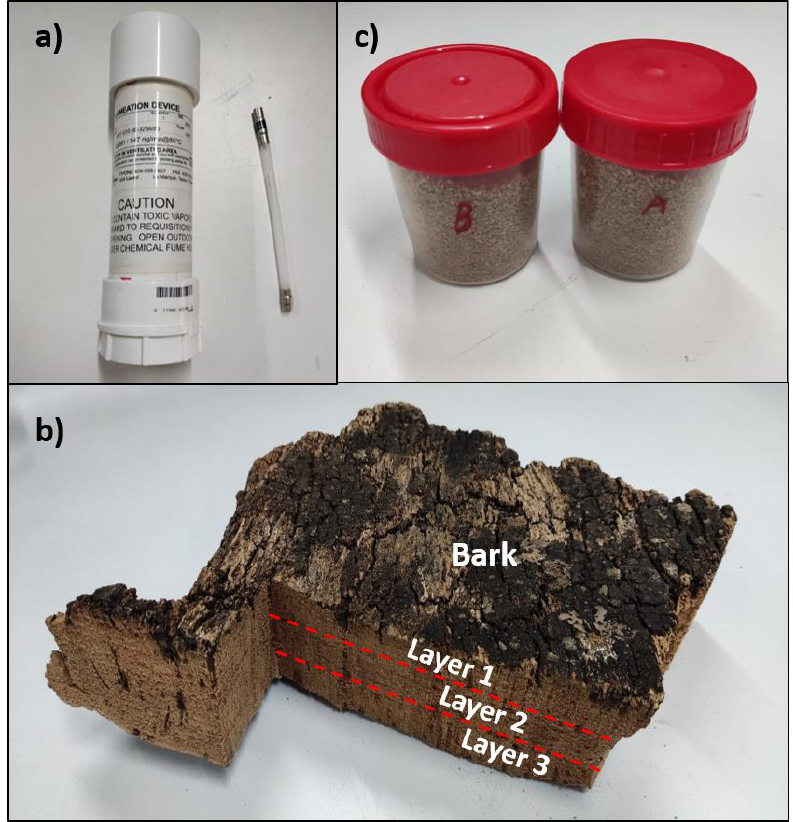
Figure 5. Samples. ( a ) Permeation tube with TCA; ( b ) Layers of bark slab; ( c ) Granulated cork samples.